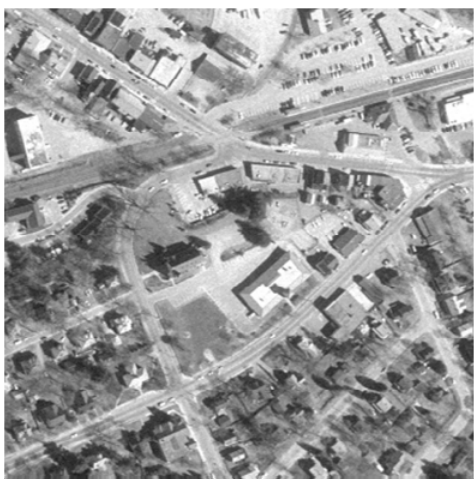
Figure 5. The original ima